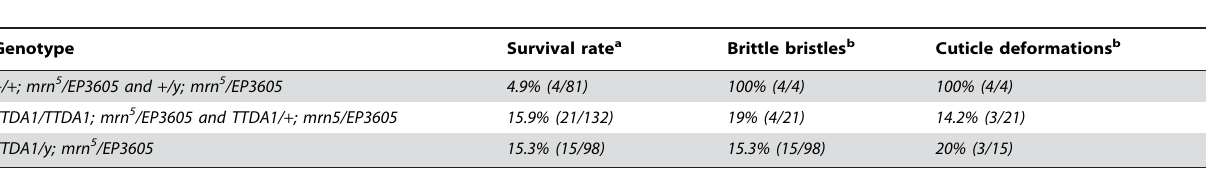
Table 1. Suppression of brittle bristle and cuticle defects by overexpression of Dmp8/TTDA in heteroallelic Dmp52 mutant flies.